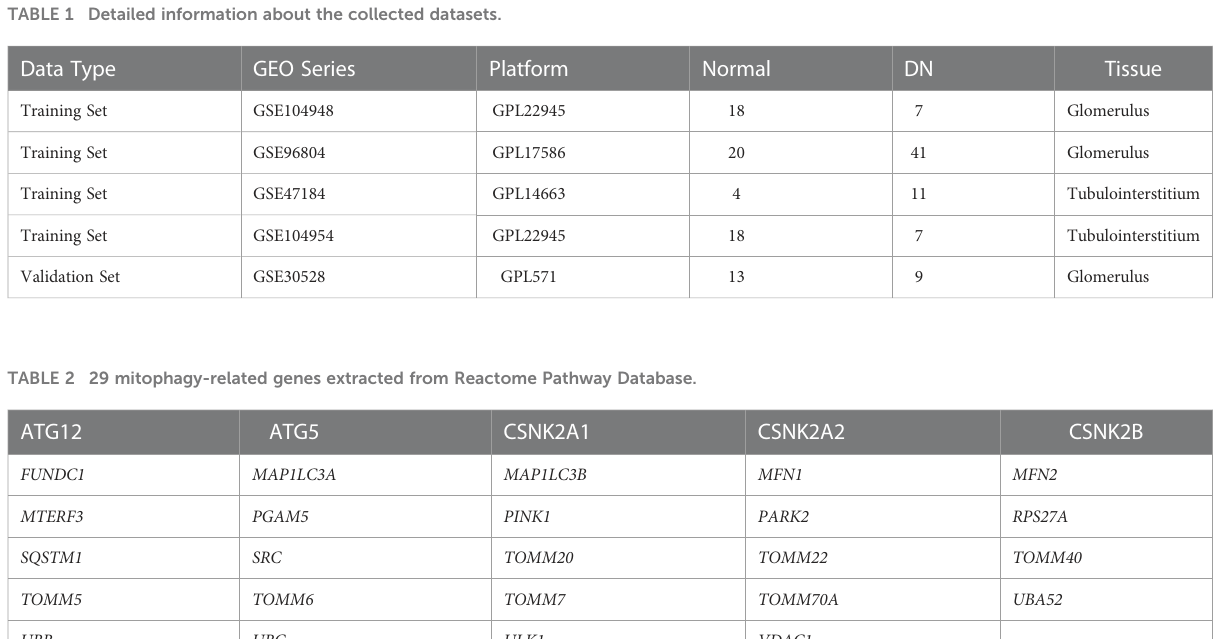
Table 1. In total, 108 glomeruli samples (57 DN, 51 living healthy donors) and 40 tubulointerstitium samples (18 DN, 22 living healthy donors) were included in our study to evaluate the expression level of MRGs. Gene symbols matched the array probes according to annotation data. A maximum expression